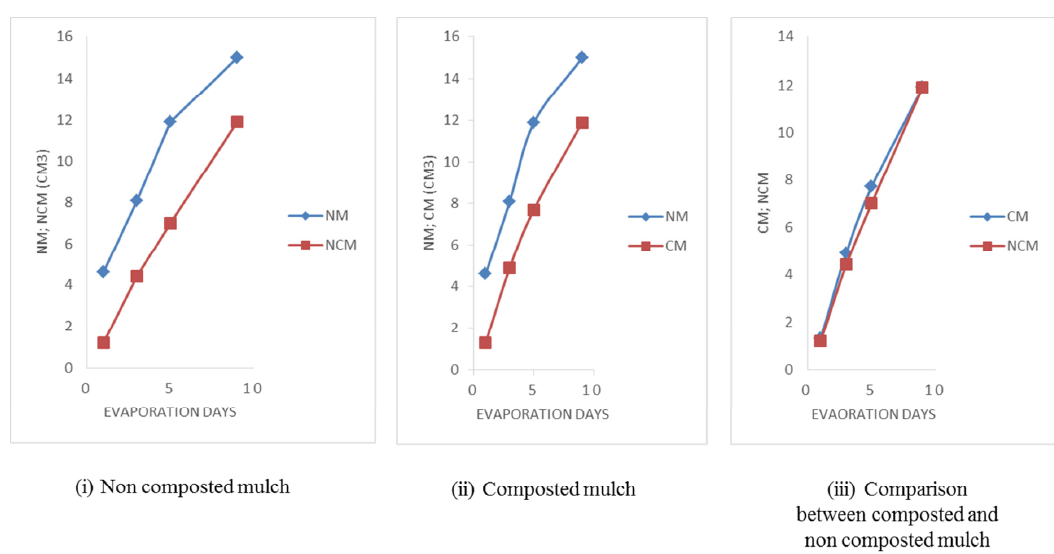
Fig. 3. Effects of Panicum mulch material on soil evaporation NM = No mulch; NCM = non- composted mulch; CM = composted